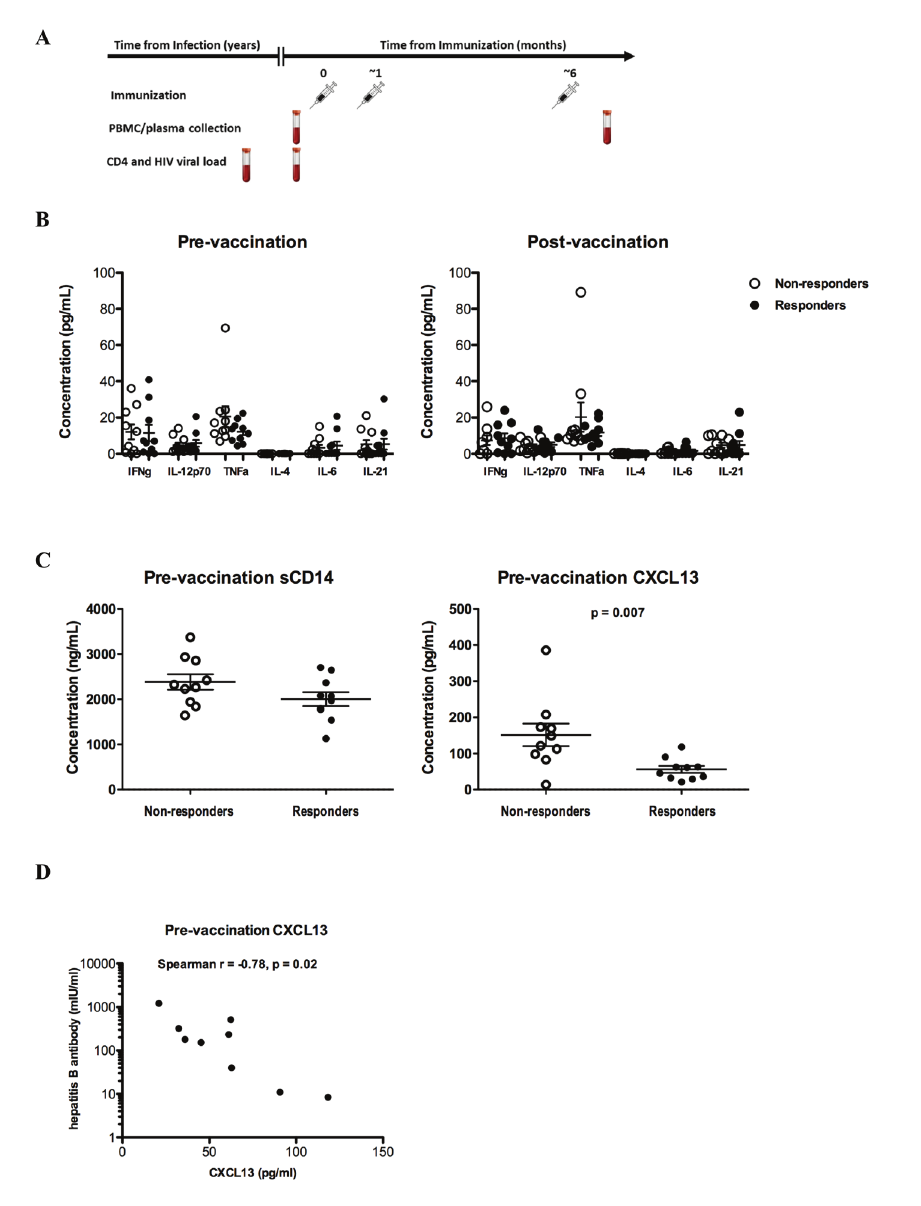
Figure 1. Baseline plasma CXCL-13 levels predict the response to HBV vaccination (A) HIV-infected subjects with and without detectable antibody responses were assessed before and after hepatitis B vacci- nation, (B) Pooled data showing the levels of several cytokines measured in plasma samples from non-re- sponders (n = 10) and responders (n = 10), (C) soluble CD14 levels in non-responders and responders are shown in the left panel , while circulating levels of the chemokine CXCL-13 pre-vaccination are shown in the right panel , (D) hepatitis B surface antibody (HbSAb) titer among responders post-vaccination. Figures are scatterplots with mean and SEM with only statistically significant P -values shown as determined by the Mann-Whitney U test (C), and Spearman rank correlation